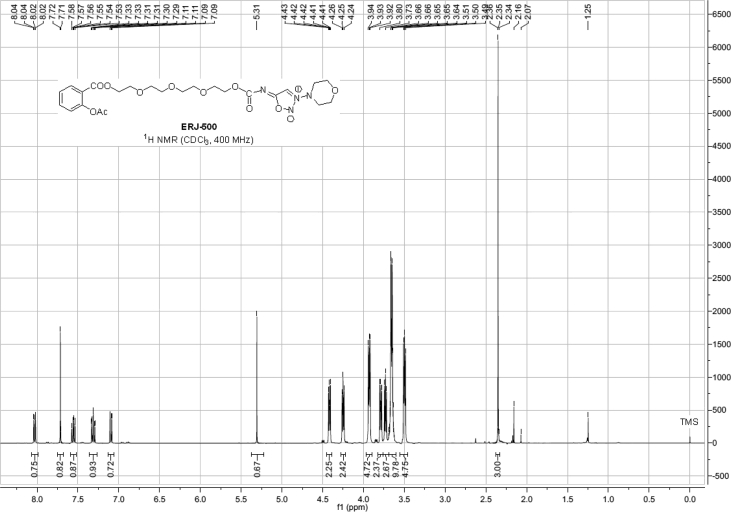
1H NMR spectra of compound ERJ-500.